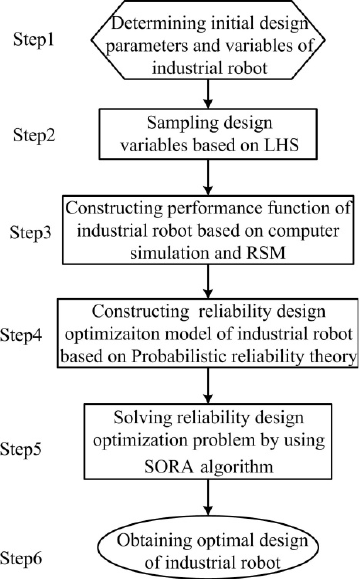
Figure 1. Main procedure of the SBRDOM.